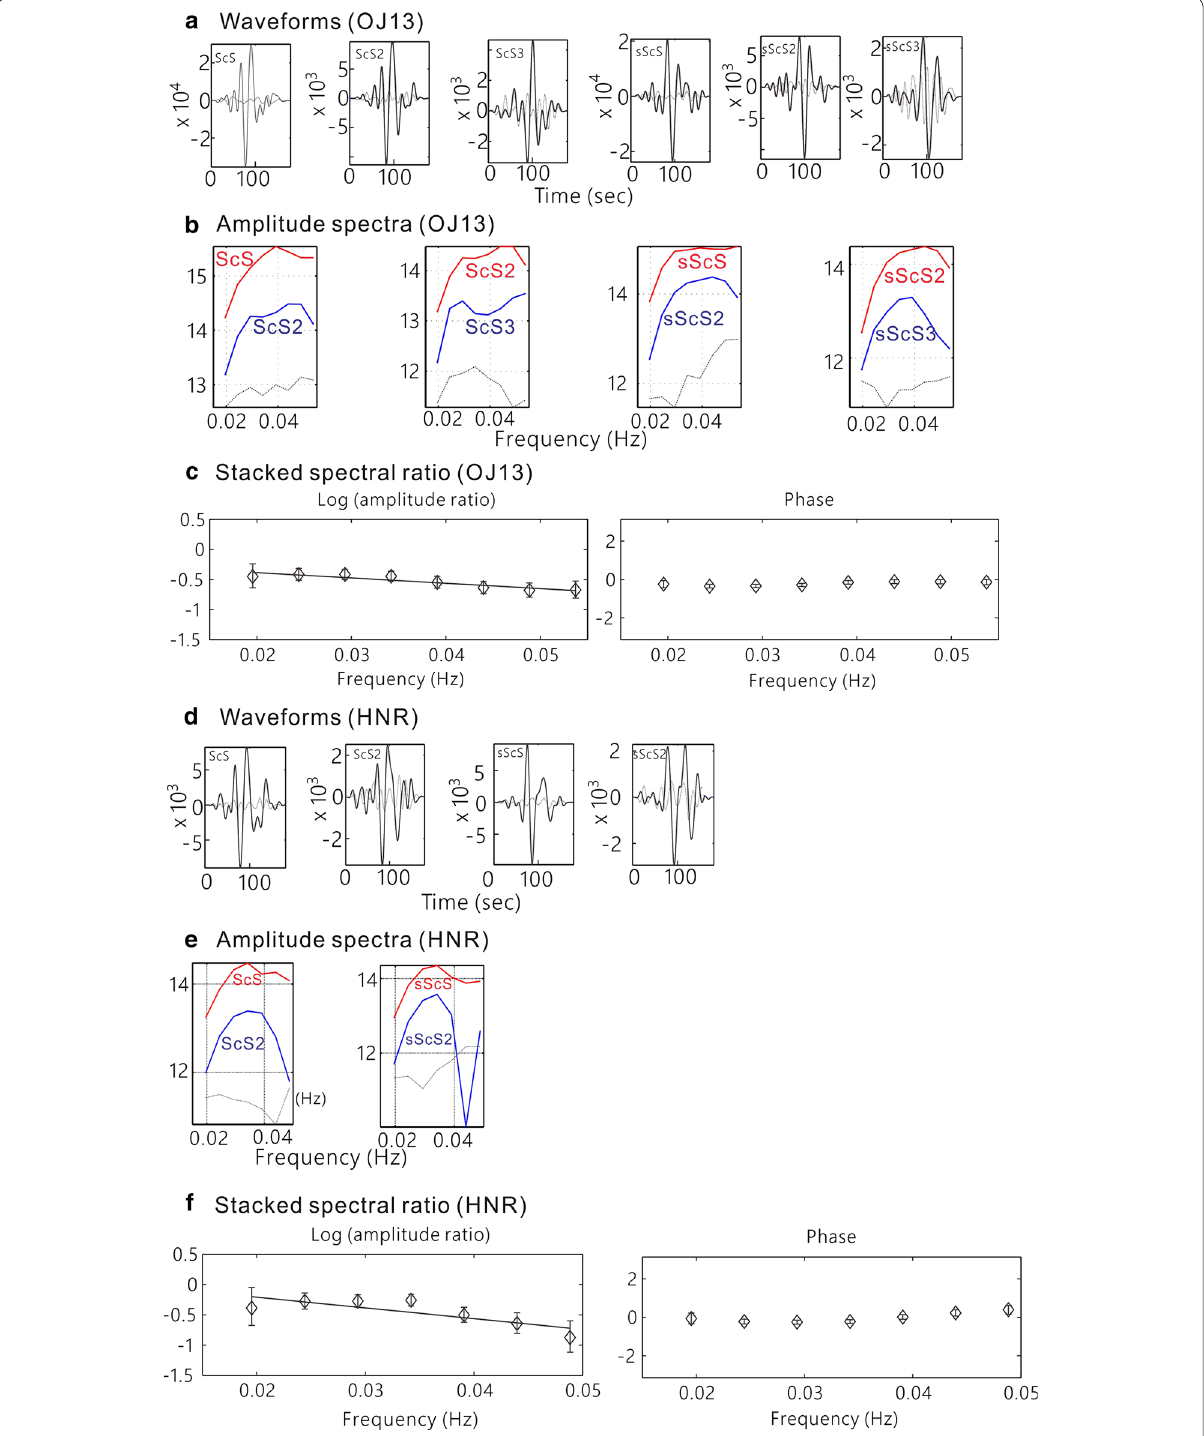
Fig. 3 Multiple ScS waveforms ( a , d ), amplitude spectra ( b , e ), and stacked spectral ratios ( c , f ) at OJ13 ( a – c ) and HNR ( d – f ) stations. In ( a , d ), the dotted curves denote the noise waveforms before arrivals of the multiple ScS waves. In ( b , e ), spectra of ScS n and sScS n are indicated by red curves and those of ScS n and sScS n by blue curves, those of noises are by dotted curves. In ( c , f ), the logarithm of the amplitude (left) and the phase + 1 + 1 (right) of the stacked spectral ratio are shown, respectively. Errors are estimated from noise spectra. A line fitting technique gives 331 and 165 54 at ±